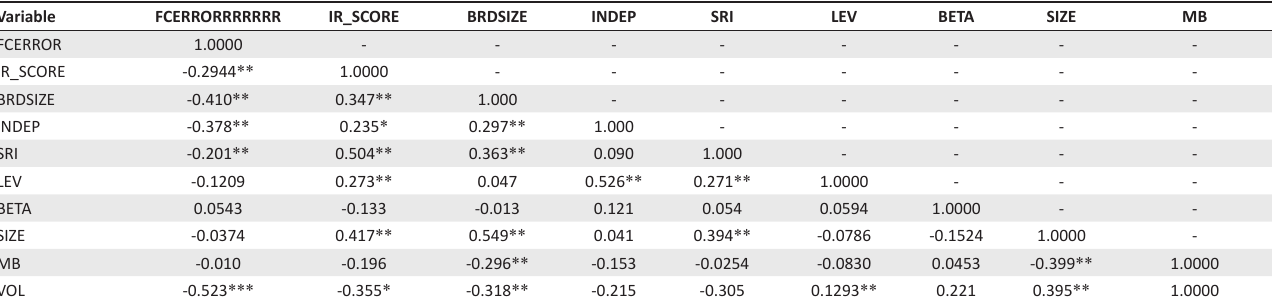
TABLE 4: Correlation: Analysts’ forecast error and independent variables. Variable